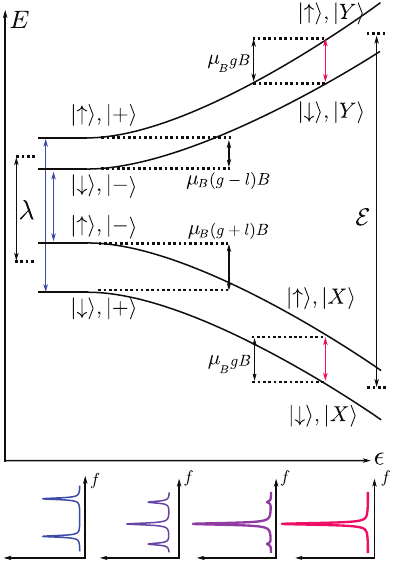
Figure 4: Behavior of 2 E spin-levels for increasing strain ( E ) in a nonzero magnetic field. In the high strain limit ( E  λ ) the system is better represented by the {| X 〉, | Y 〉} strain basis than the {| + 〉, |−〉} orbital basis. The colored arrows represent the observable electron paramagnetic resonance (EPR). For example, EPR spectra for increasing strain are shown at the bottom of the figure, with increasing strain from left to right. The spectra changes from exhibiting spin-orbit, orbital Zeeman, and spin Zeeman behavior to simple spin Zeeman